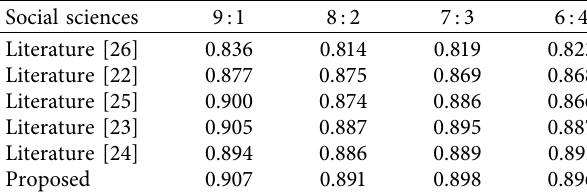
Table 5: Prediction performance comparison (social